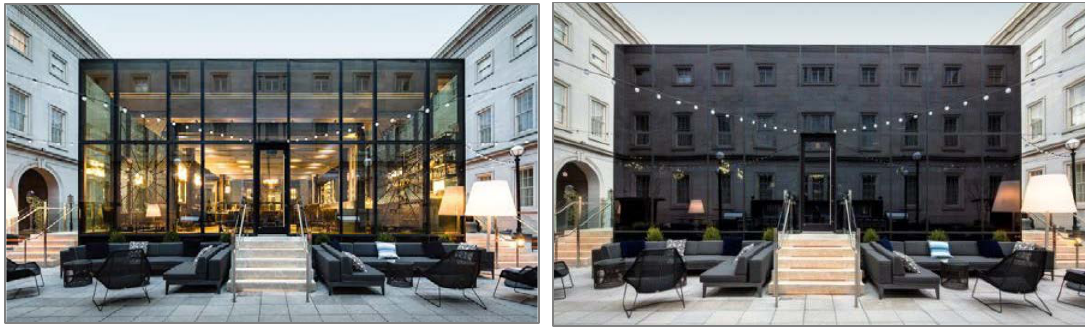
Figure 2 Transparent and tinted states of electrochromic smart window in Dirty Habit DC facade (URL-2)